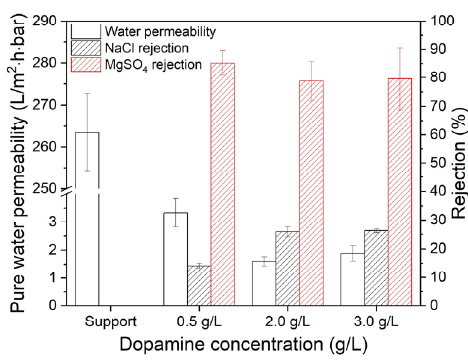
Figure 7. Effect of dopamine concentration (coating temperature: 25 °C) on the UPW permeability and rejection of NaCl and MgSO 4 . Rejection is measured with a salt concentration of 2 g/L at 5 bar. Average values and standard deviations represent at least four (UPW permeability) and two (rejection measurements) measurements, respectively.